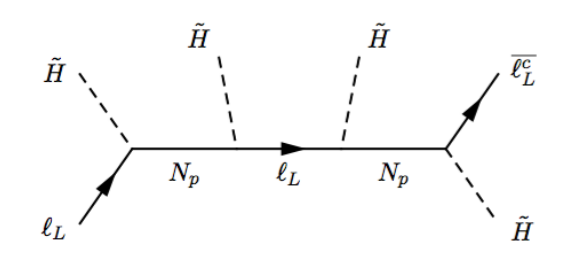
Figure 2 . Full theory interactions inserted on the tree level propagator to obtain four external H (cid:12)elds. These scattering contributions only perturb the low energy neutrino mass matrix due to the EOM e(cid:11)ect of L 5 modifying eq. (2.7). Note that when the neutrinos are integrated out in sequence, local contact operators result that lead to even more mass matrix perturbations, as shown in (cid:12)gure